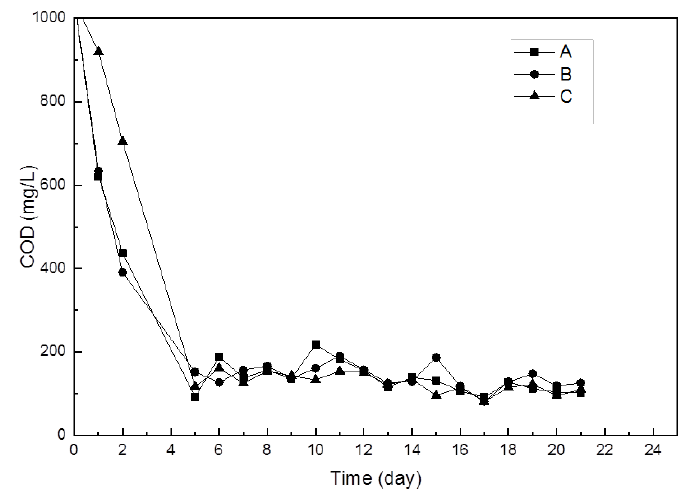
Figure 4. Chemical oxygen demand (COD) during the continuous 21-day incubation. Quorum quenching (QQ): in the presence of HG10 beads. VB: in the presence of vacant beads. CT: No beads were added.